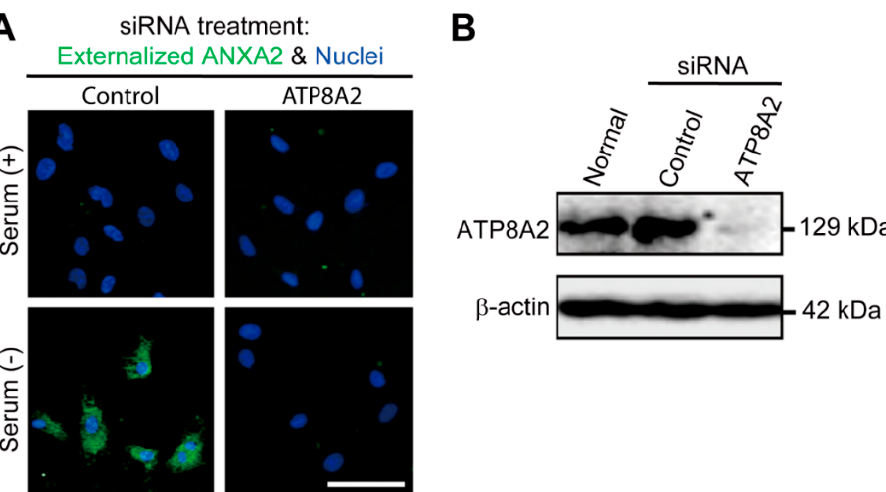
Figure 4. ATP8A2 is involved in flop-out of annexin A2 under serum-free conditions. ( A ) Loss of annexin A2 (ANXA2) flop-out by the treatment of siRNA for ATP8A2. C6 glioma cells without permeabilization were treated with siRNA for ATP8A2, and ANXA2 immunocytochemistry was performed at 3 h after serum-free stress. Images are representative of at least 3 independent exper- iments. ( B ) Immunoblot evidence for the knock-down of ATP8A2 by siRNA treatment in C6 gli- oma cells. Scale bars, 20 μ m.